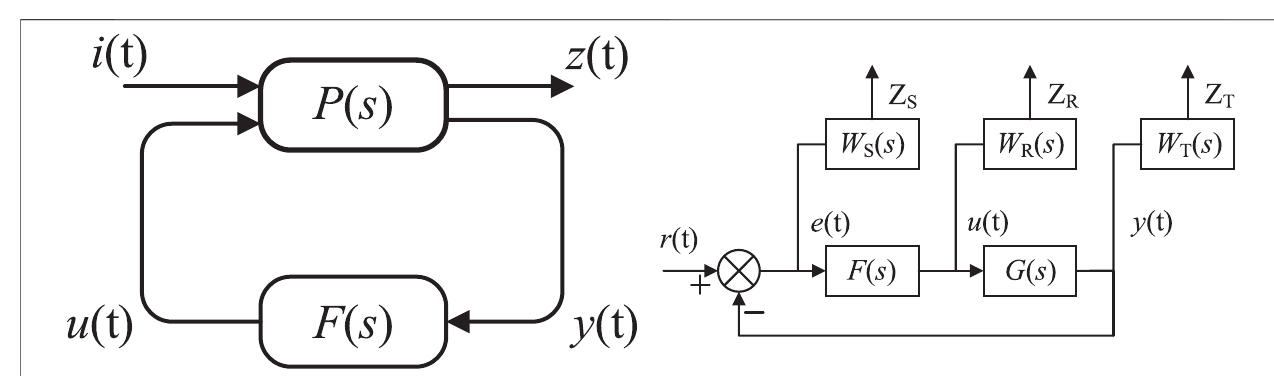
FIGURE 3 | A general description of the robust control scheme. (A) H ∞ standard question structure diagram and (B) mixed sensitivity problem of the model.